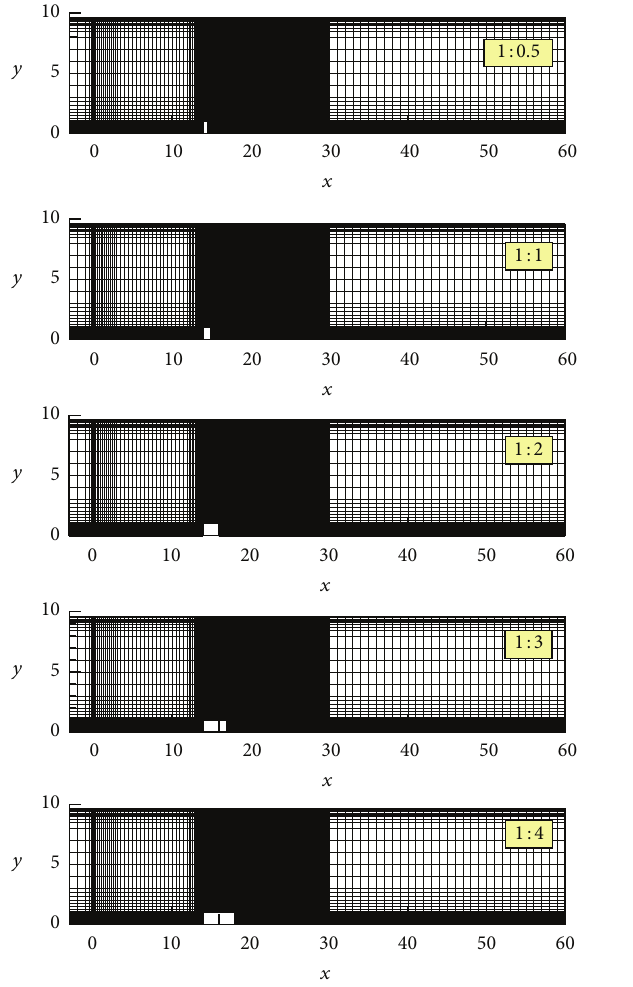
Figure 1: Computational meshes for the five rib cases.